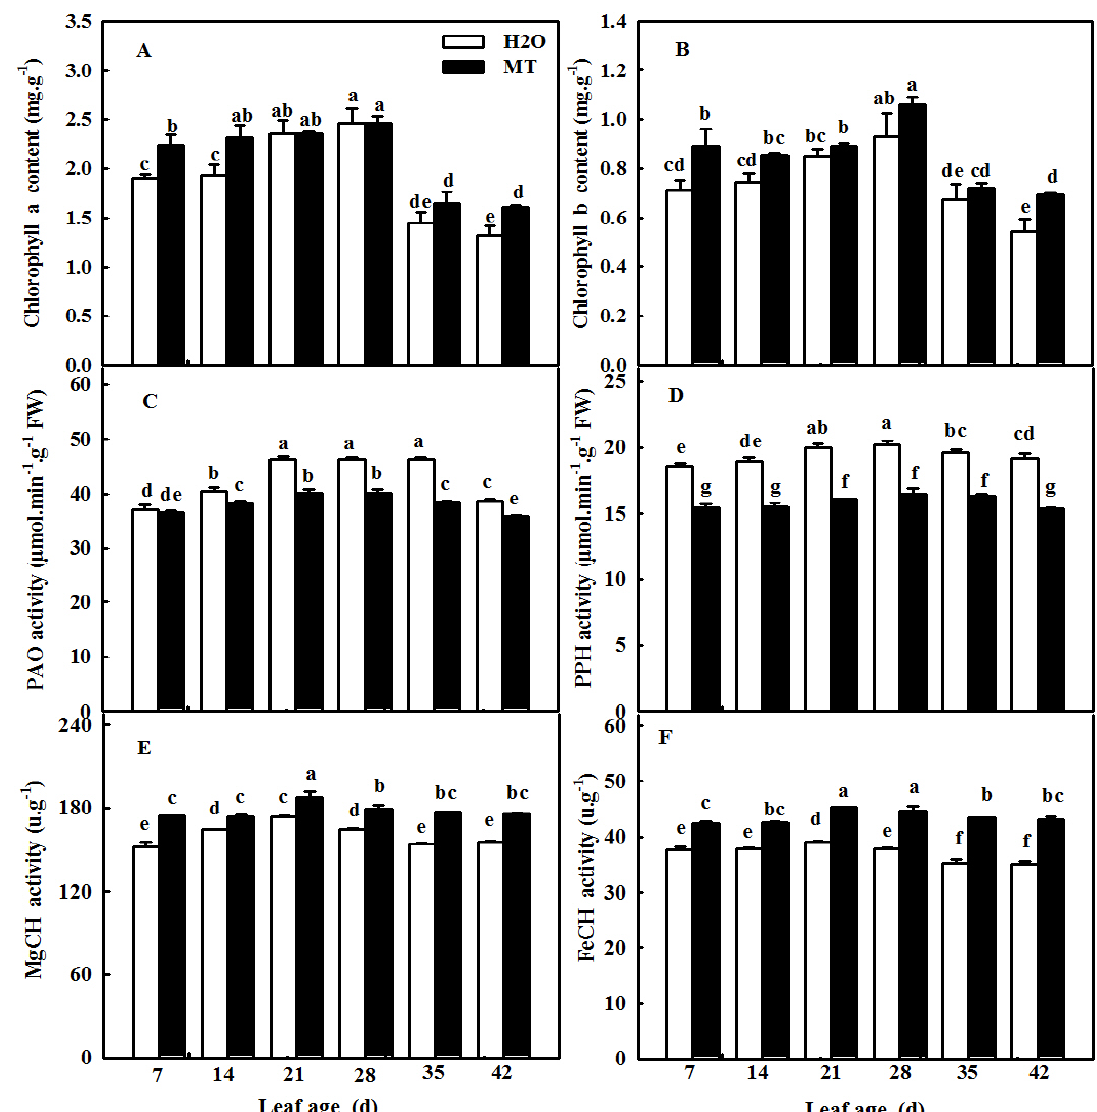
Figure 6. The effect of exogenous MT on chlorophyll metabolism in different age leaves of cucumber plants in a solar greenhouse. ( A ) Chlorophyll a content; ( B ) chlorophyll b content; ( C ) PAO activity; ( D ) PPH activity; ( E ) MgCH activity; ( F ) FeCH activity. At the three-leaf stage, the new leaf at the top was labeled 0 days and then labeled at 7, 14, 21, 28, 35, and 42 days. Meanwhile, cucumber plants were sprayed with 100 μ mol·L − 1 MT every 7 days, and plants treated with H 2 O were the control. The different leaf-age leaves were sampled for the determination of chlorophyll contents and relative enzyme activities. All values shown are mean ± SD ( n = 3). a, b, c, d, e, f and g indicate that mean values are significantly different among samples ( p < 0.05).